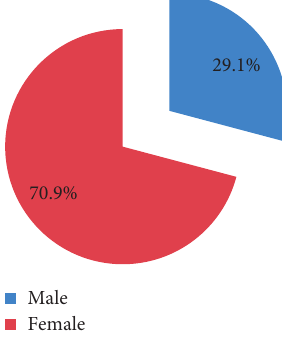
Figure 7: Gender Table 1: Correlation of operative time and duration of hospital stay with RS.